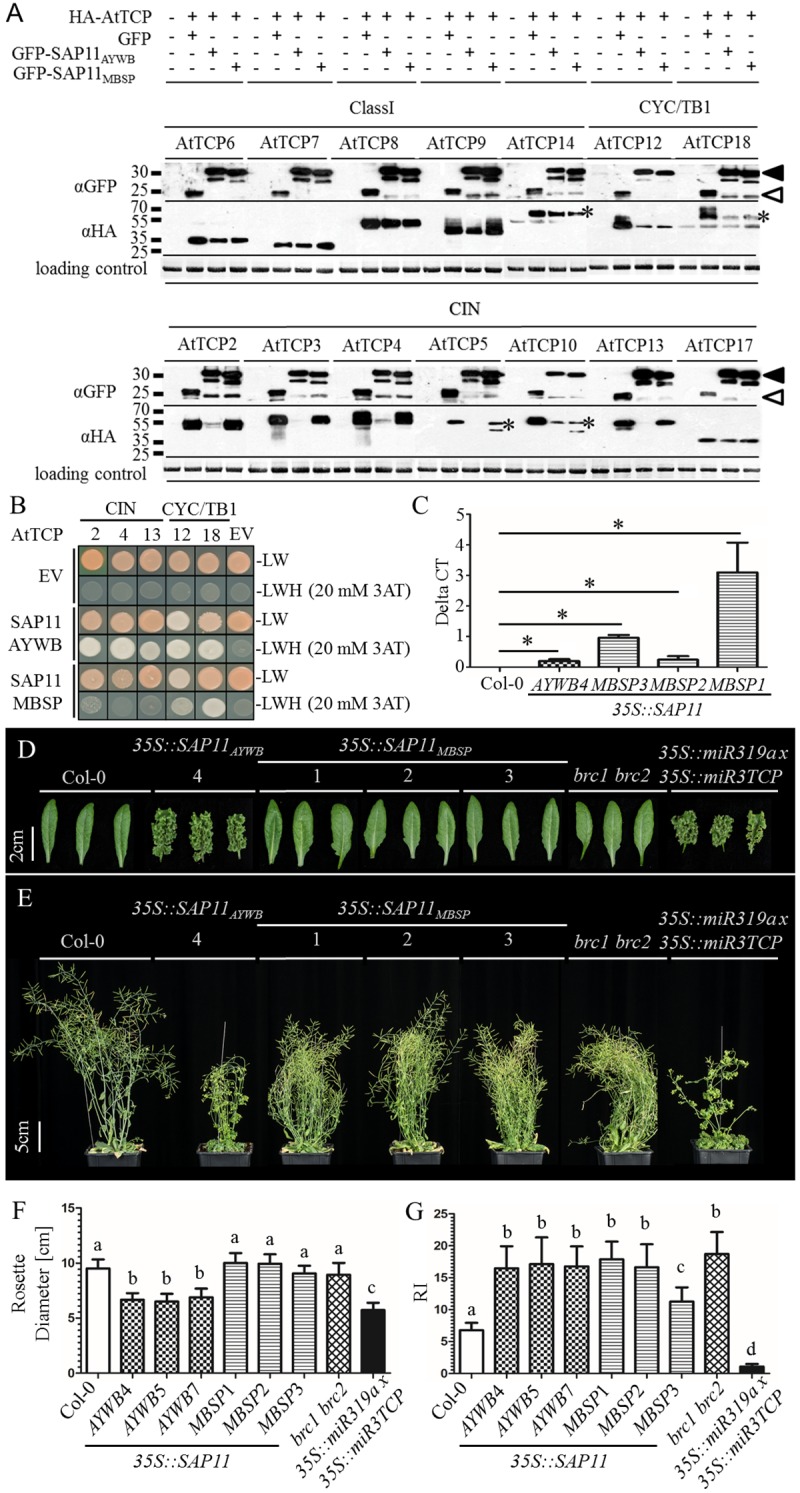
SAP11AYWB and SAP11MBSP interactions with A. thaliana TCP transcription factors.(A) Western blots of A. thaliana protoplast destabilization assays; SAP11AYWB and SAP11MBSP destabilize the CYC/TB1 TCPs BRC1 (AtTCP18) and BRC2 (AtTCP12) and SAP11AYWB also all class II CIN-TCPs, whereas the SAP11 homologs did not destabilize class I TCPs. GFP-tagged SAP11 (filled arrowheads) or GFP alone (open arrowheads) and HA-tagged TCPs were detected with specific antibodies to GFP and HA, respectively, as indicated at left of the blots. *band of the correct size in case of multiple bands on the blots. Loading controls: Amidoblack-stained large RUBISCO subunit. (B) Yeast two-hybrid assays of interactions of SAP11AYWB with CIN and CYC/TB1-TCPs and SAP11MBSP with CYC/TB1-TCPs. Positive interactions are visible by yeast growth on SD-LWH selection media containing 20 mM 3-Amino-1,2,4-triazole (3AT). EV = empty vector controls showing absence of auto activations. (C) qRT-PCRs of transcripts of SAP11AYWB and SAP11MBSP transgenes in A. thaliana lines shown in D-F. *p<0.01, students t-test compared to Col-0, n = 3. Functional transgene expression in the lines 35S::SAP11AYWB5 and 35S::SAP11AYWB7 has been reported previously [8]. (D-G) 35S::SAP11AYWB stable transgenic A. thaliana (Col-0) lines phenocopy both the A. thaliana brc1-2 brc2-1 (brc1 brc2) double (Col-0) mutant and 35S::miR319a x 35S::miR3TCP stable transgenic A. thaliana (Col-0) lines and 35S::SAP11MBSP transgenic lines phenocopy only the A. thaliana brc1 brc2 mutant. Nine-week-old plants were phenotyped for rosette leaf morphology (D), overall appearance of side views (E), rosette diameters (F) and numbers of primary branches emerging from the rosettes (G). (F, G) Error bars denote standard errors (n = 24). Letters indicate groups that are statistically different (one-way ANOVA with Tukey´s Multiple Comparison Test).